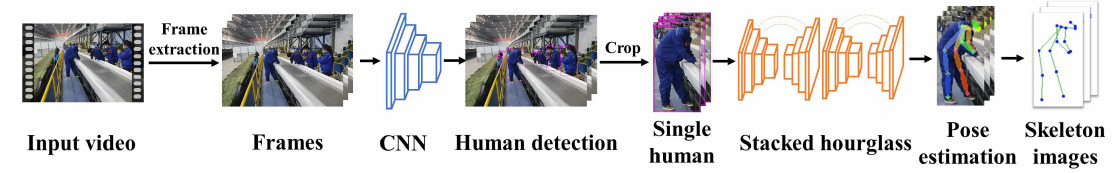
Figure 2. The entire process of human pose estimation. Convolutional neural network